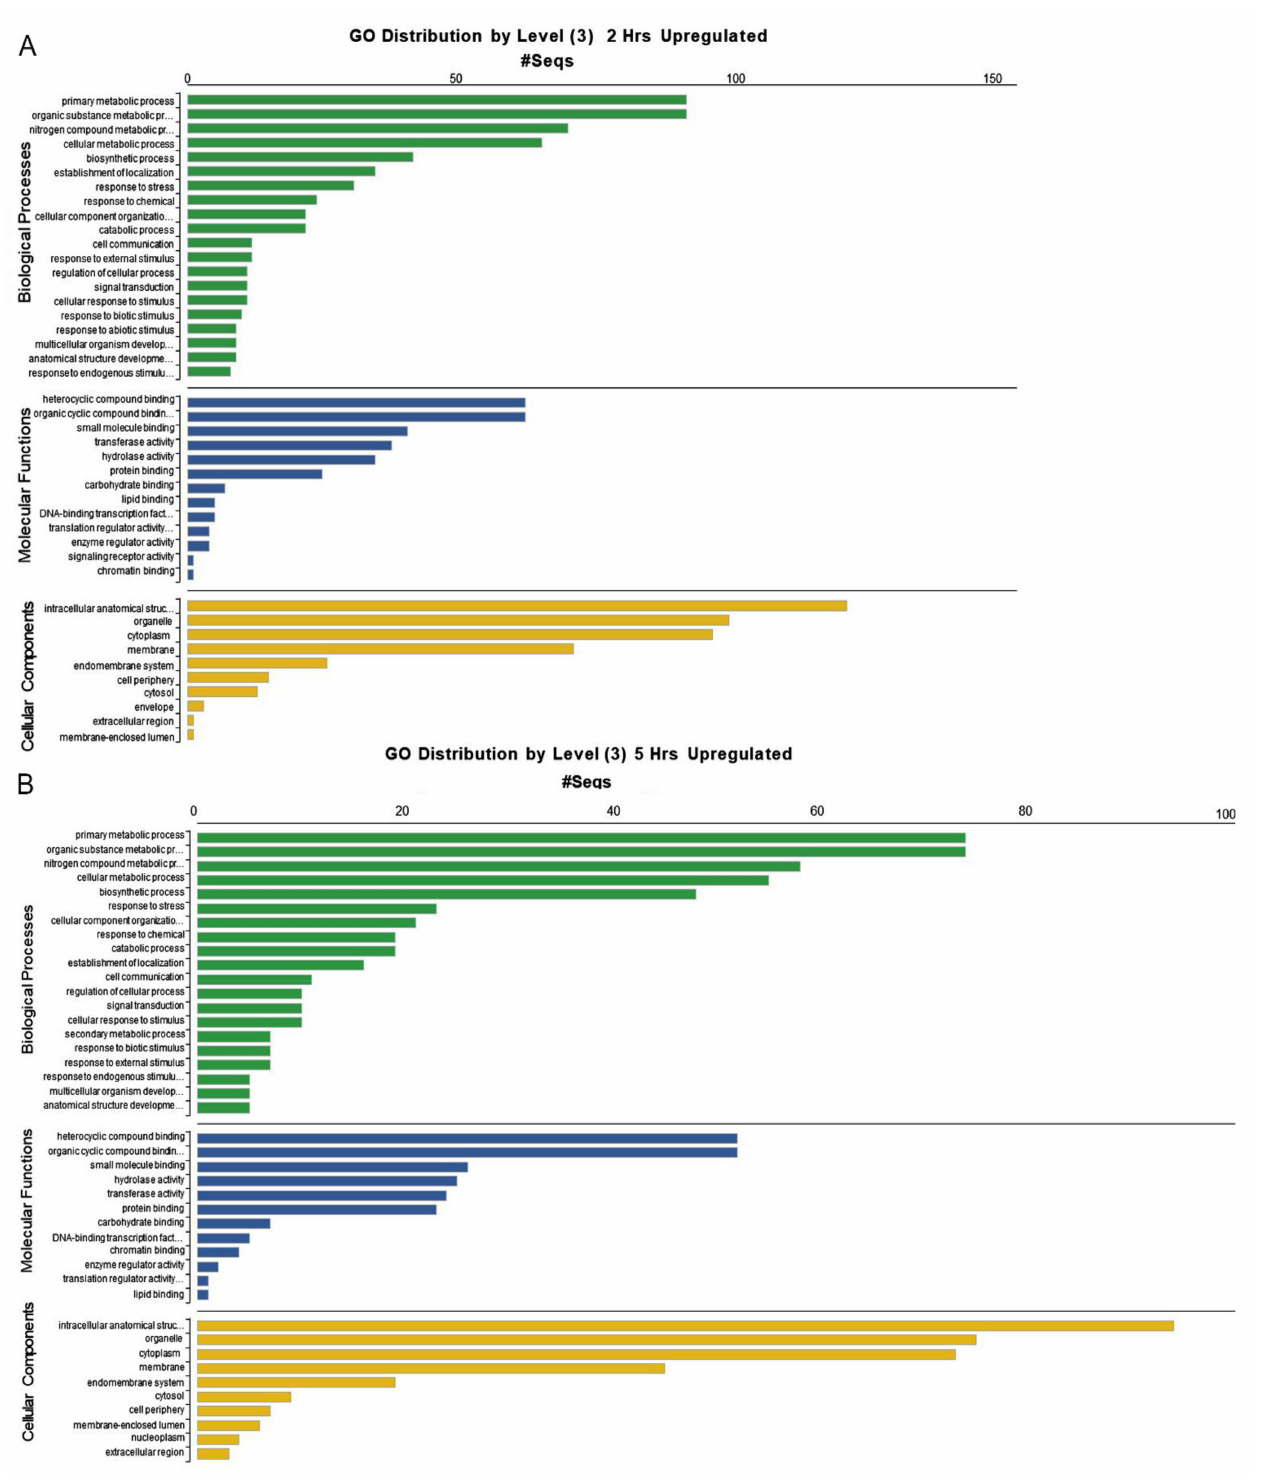
Figure 2. Level 3 Gene Ontology distribution of DEGs. Charts show the upregulated genes in TM-treated leaf tissues at ( A ) 2 and ( B ) 5